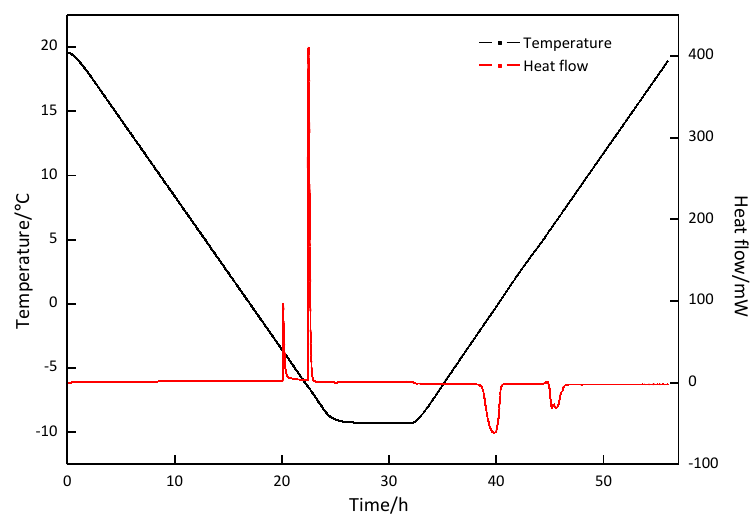
Figure 7. Heat flow and temperature curve at 20.0~ −8.8 °C and 2.5 MPa.